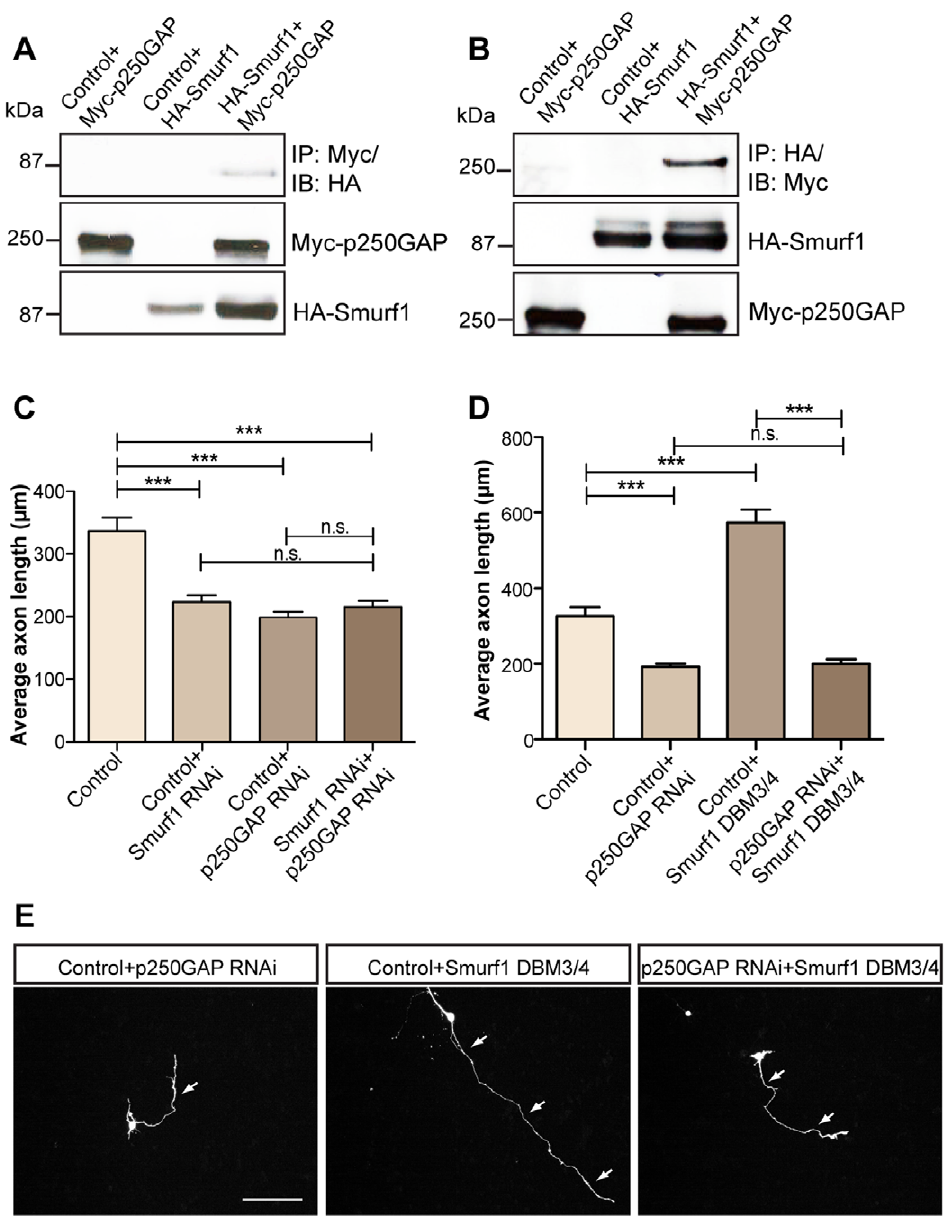
Figure 5. Association of p250GAP with Smurf1 regulates axon growth. A. 293T cells were transfected with control vector pCMV5 and Myc- p250GAP, or control pcDNA3 vector and HA-Smurf1, or both HA-Smurf1 and Myc-p250GAP plasmids and the lysates were subjected to immunoprecipitation with the Myc antibody followed by immunoblotting with the HA antibody. B. Reciprocal co-immunoprecipitation of A . C. Granule neurons transfected with control U6, U6 and Smurf1 RNAi, or U6 and p250GAP RNAi or both Smurf1 RNAi and p250GAP RNAi plasmids were analyzed at DIV 4 as described in 2B. A total of 467 neurons were measured (ANOVA, ***p , 0.0001, n.s.=not significant, values indicate mean + SEM). D. Granule neurons transfected with control U6, pCMV5 and p250GAP RNAi, or U6 and Smurf1 DBM3/4 or both p250GAP RNAi and Smurf1 DBM3/4 plasmids were subjected to axon growth assays at DIV 4 as described in 2B. A total of 324 neurons were measured (ANOVA, ***p , 0.0001, n.s.=not significant, values indicate mean + SEM). E. Representative images of transfected neurons in D. Scale bar equals 100 m m. Arrows indicate